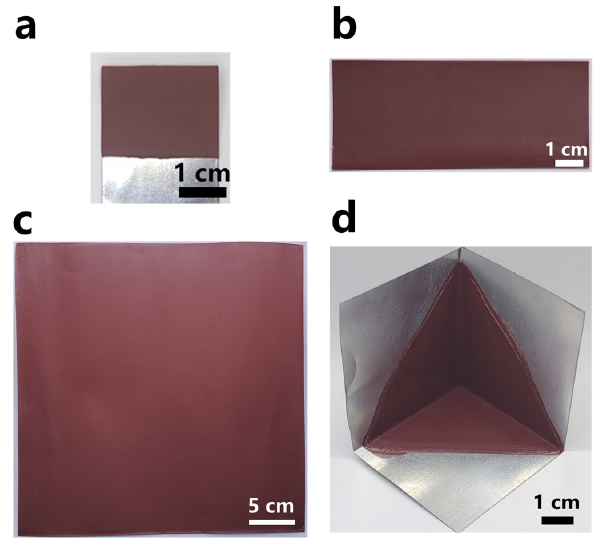
Figure 5. Film formed using ATH 20 wt.% + RP 10 wt.% mixed emulsion ( a–c ); planar film formed on areas of different sizes; ( d ) film formed at non-planar corners.